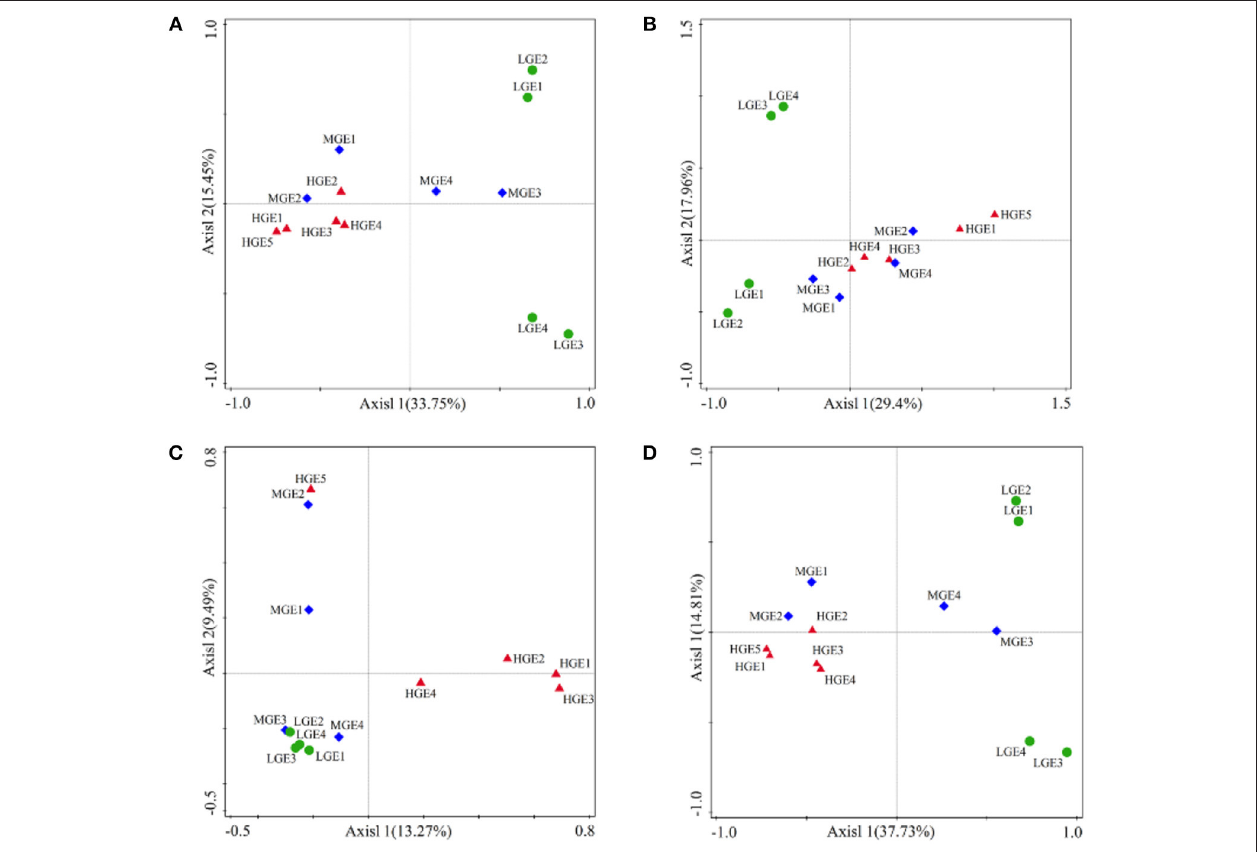
FIGURE 5 | PCoA based on Bray-Curtis similarities of bacterial communities among three elevational gradients. (A) All; (B) Generalists; (C) Specialists; (D) Other taxa. High elevational gradient (HEG) (2900–3055m) including five different elevation sampling sites (HEG1, HEG2, HEG3, HEG4, and HEG5), both medium elevational gradient (MEG) (2500–2800m) (MEG1, MEG2, MEG3, and MEG4) and low elevational gradients (LEG) (2000–2300m) (LEG1, LEG2, LEG3, and LEG4) including four different elevation sampling sites.